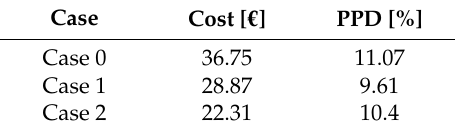
Table 5. HVAC plant daily operating costs and predicted percent dissatisfied (PPD) mean